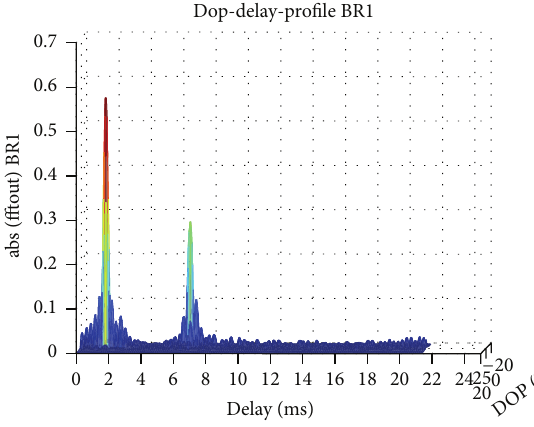
Figure 12: Observed power delay